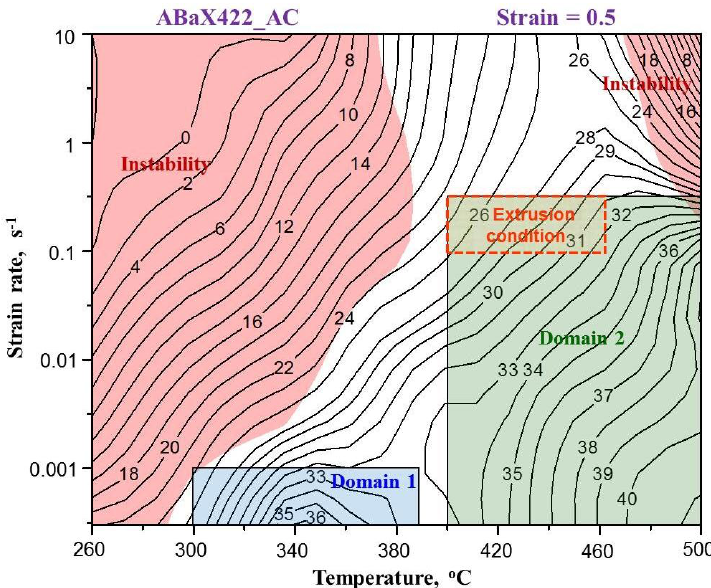
Figure 3. Processing map for the as-cast Mg–4Al–2Ba–2Ca alloy at a true strain of 0.5. The numbers associated with the contours indicate efficiency of power dissipation in percent, and the instability area is shaded in red. The dotted orange color box indicates the extrusion process condition utilized.